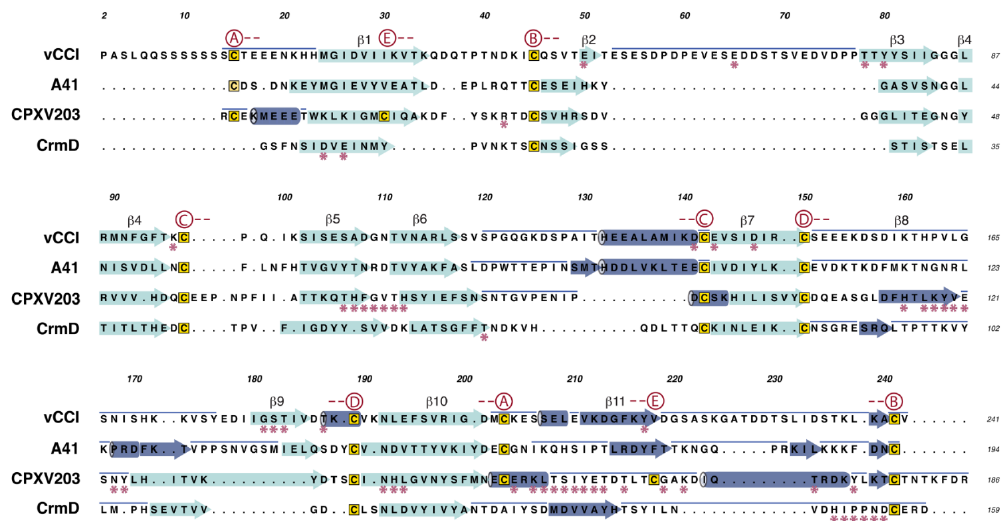
Figure 3. Structure based sequence alignment for the PIE domains of Figure 1. Numbering of the core β strands (cyan) is given above the sequences. The decorations are indicated (dark blue), with new strands as arrows, helices as cylinders, and extended coil as a blue line above the sequence. The decorations occur as insertions primarily to the β 6– β 7 loop, the β 7– β 9 loop, and at the C-terminus. Disulfide bond cysteines are marked above the alignment, with red circles containing letters of the different disulfide-bond pairs (A, B, C, D, or E) as indicated in Figures 1 and 2. The contacts made by ligand are marked with stars (magenta) under each sequence.